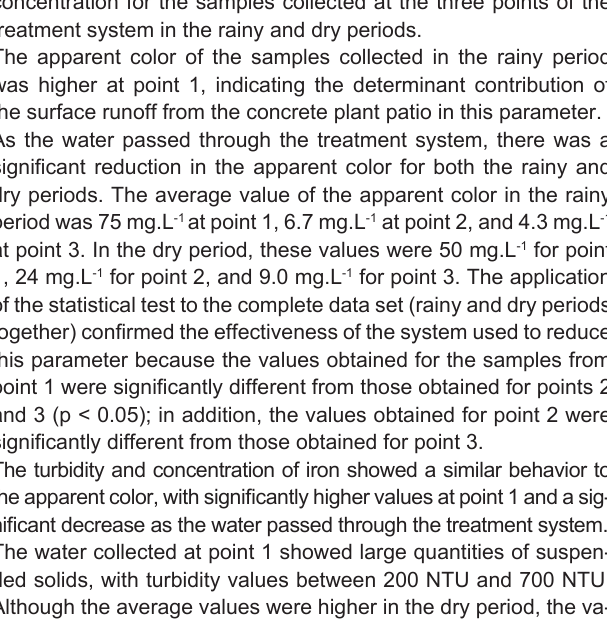
Figure 3 – Chloride concentration of samples collected in the rainy period (collections C5 to C8). The white bars show the values obtained for the samples at point 1, the light gray bars show the values obtained for the samples at point 2, and